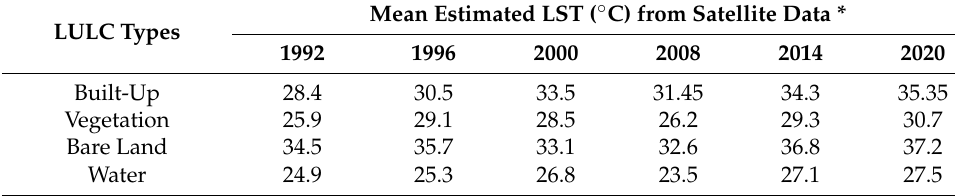
Table 3. Spatiotemporal Distribution of LST.